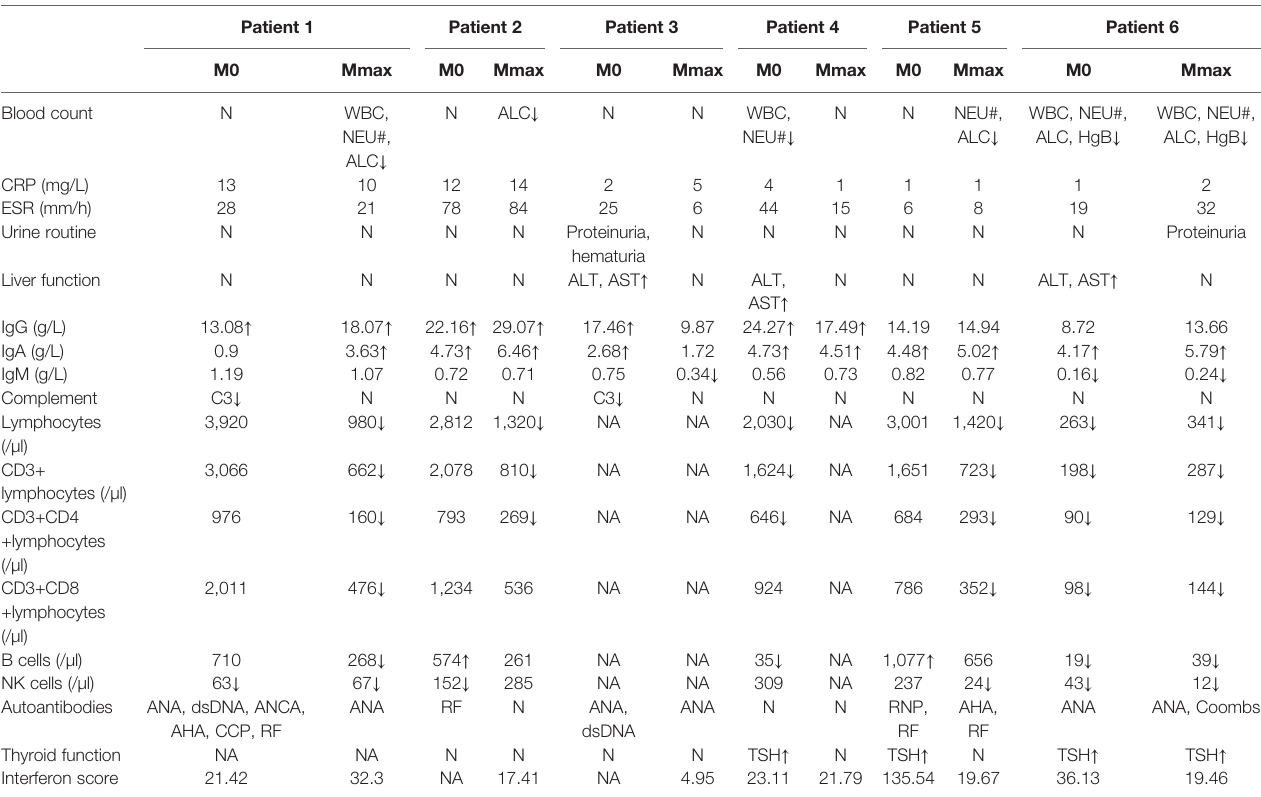
TABLE 2 | Laboratory parameter changes before and after jakinibs